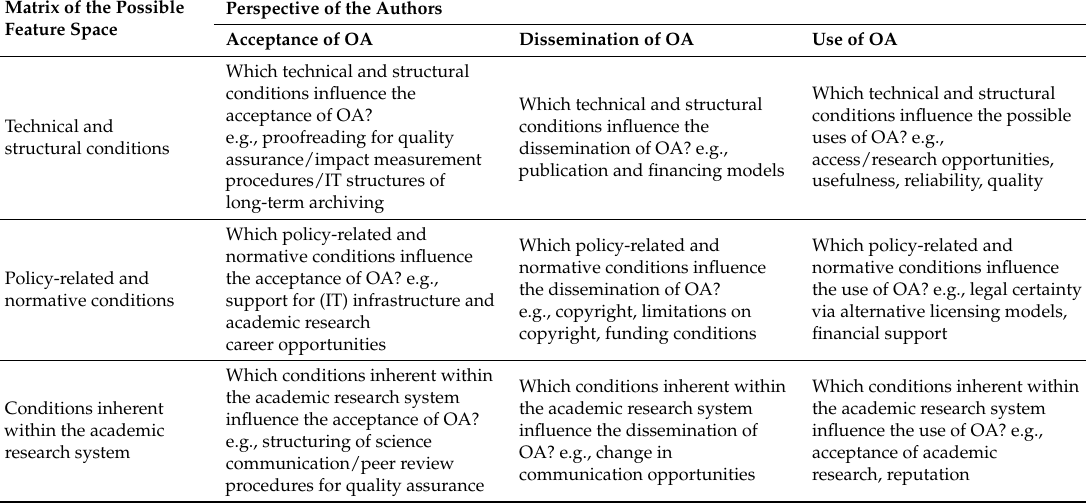
Table 1. RLTW 1 Matrix on possible conditions for the acceptance, dissemination and use of Open Access in vocational education and training